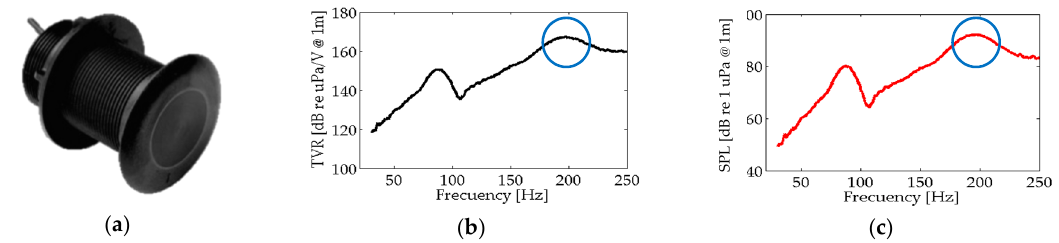
Figure 2. Technical specification for Airmar P19. ( a ) On the right, transducer emitter Airmar P19; ( b ) TVR in 200 kHz; ( c ) SPL in 200 kHz.